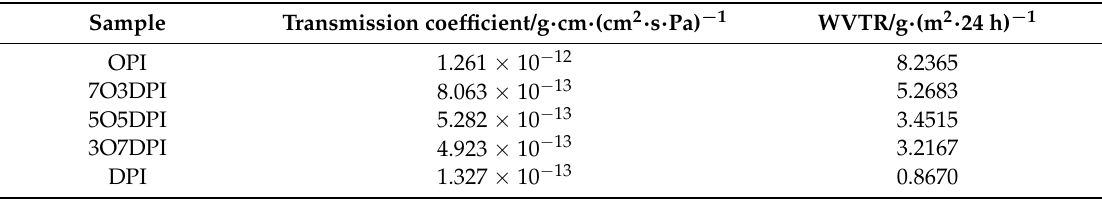
Table 5. Water barrier properties of polyimide films